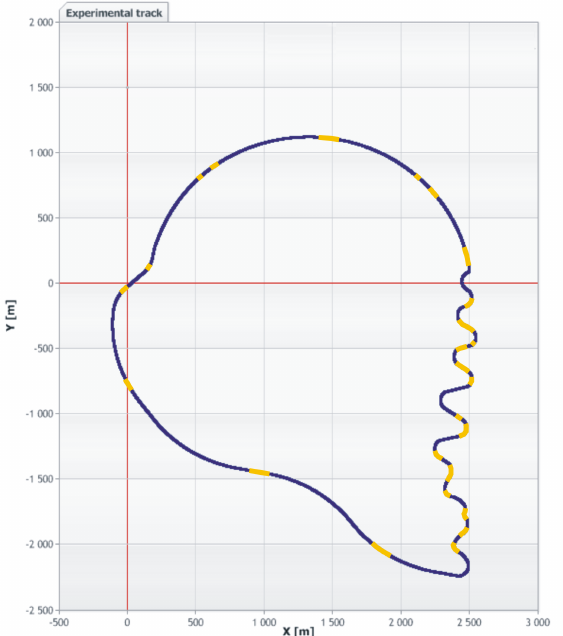
Figure 2. Experimental track